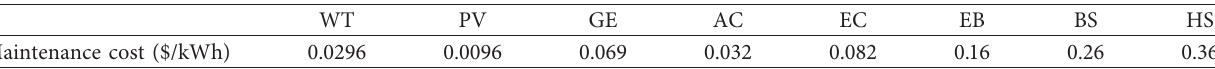
Figure 9: Real-time price of electricity. Table 8: Equipment maintenance fee.